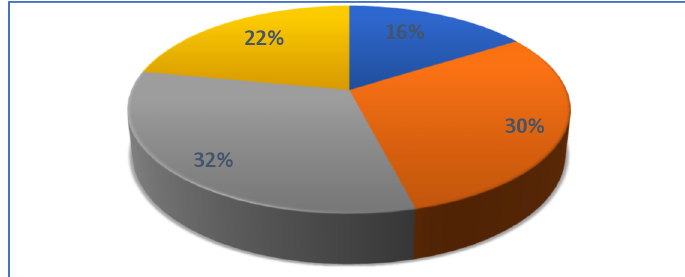
Figure 3. The percentage share of investigated projects in di ff erent nexuses in